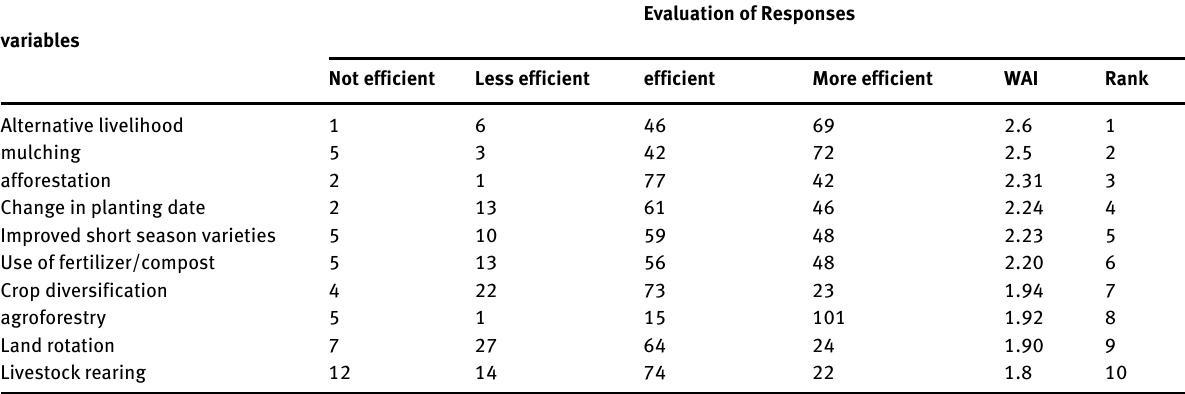
Table 5: Assessment of perceived best climate change adaptation practices